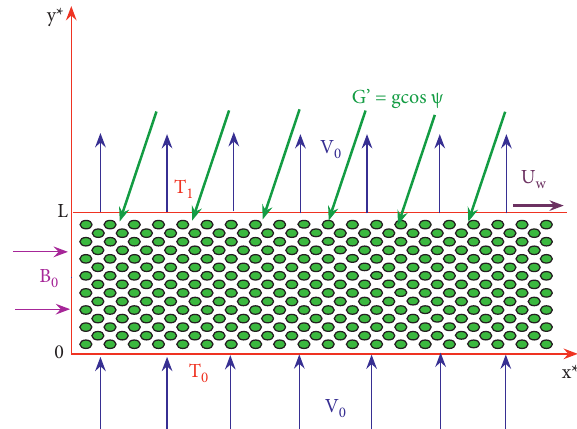
Figure 1: Physical model and coordinate